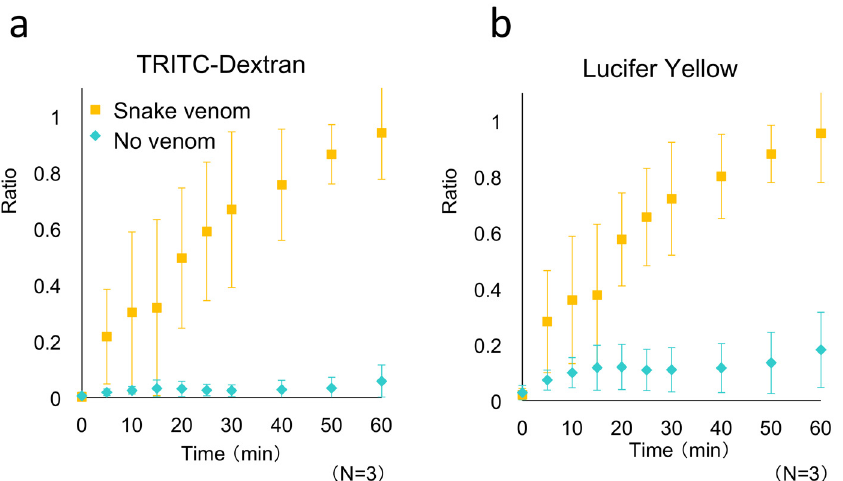
Fig 7. Permeability of BECs and LECs stimulated with or without habu snake venom. Permeability tests were performed after a 24-h cell culture (BEC-LEC coculture). Samples: (yellow squares) and control (blue diamonds). The values are presented as means ± SD. The fluorescent tracers used were (a) TRITC-dextran and (b) Lucifer Yellow. The t -test results showed that the 60-min values obtained without (control) and with stimulation with habu snake venom were significantly different: P < 0.0001, for both (a) and (b). Each data point was obtained from three devices (n =